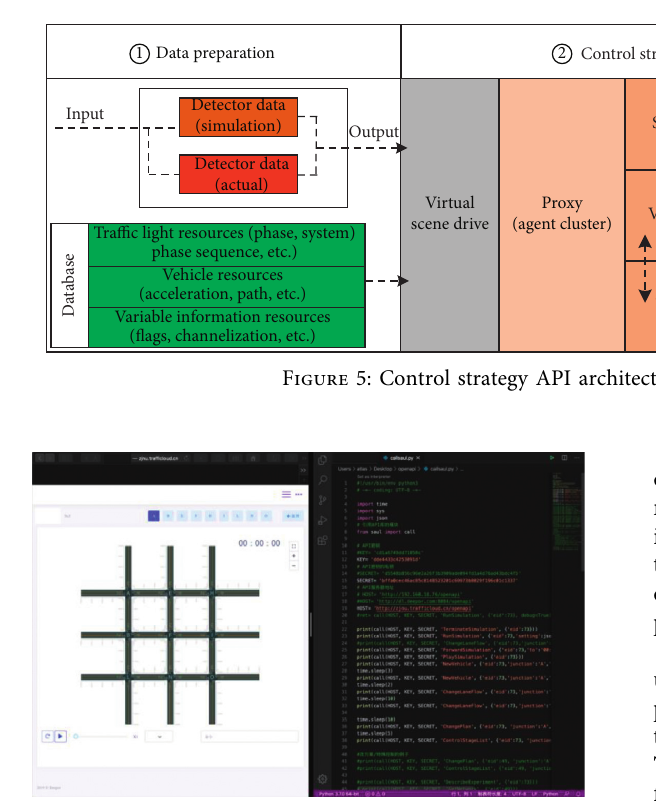
Figure 6: Control strategy software